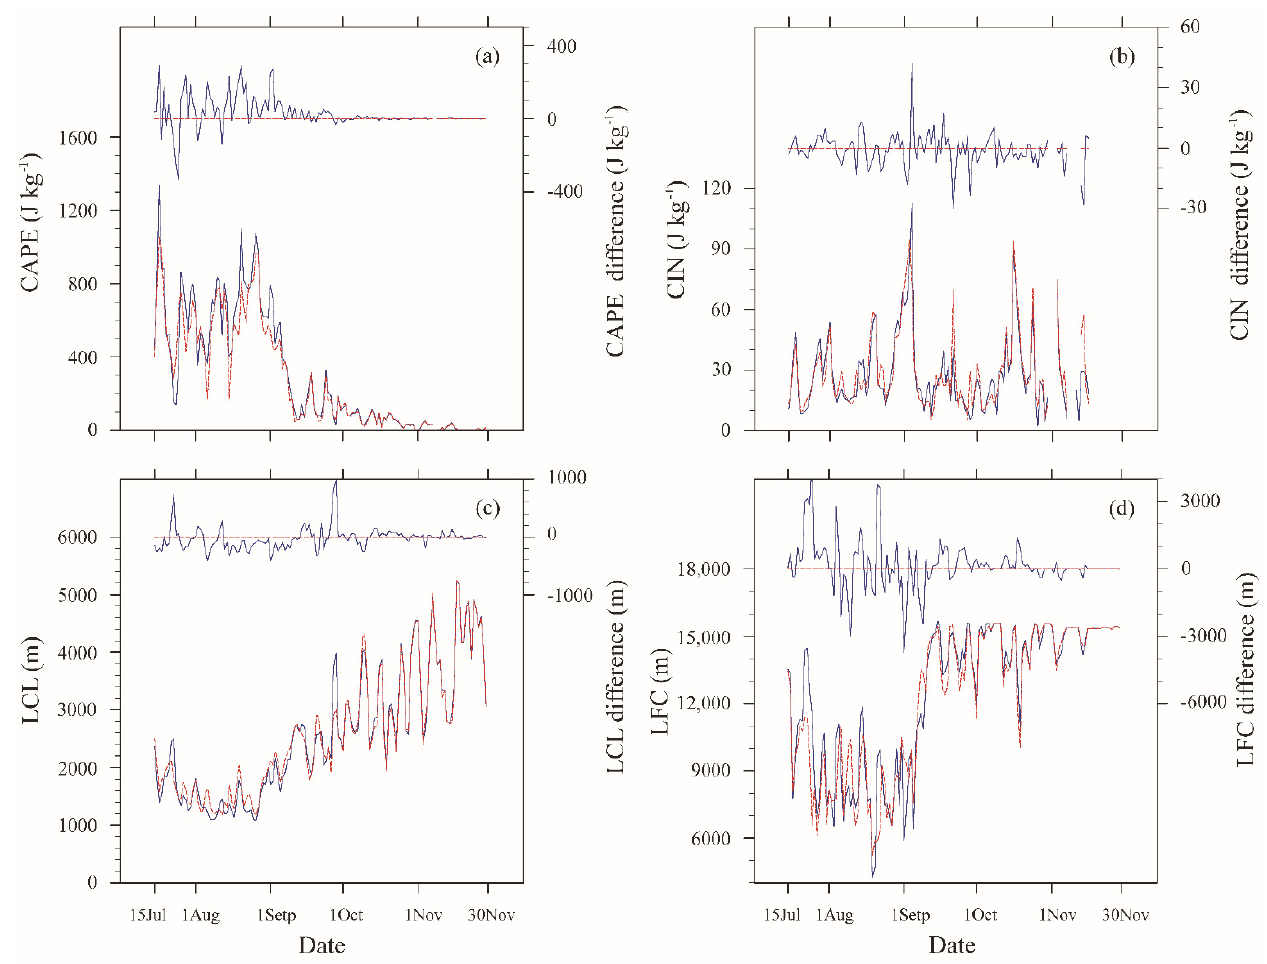
Figure 10. Temporal variations of the TRSR basin averaged values for the boundary layer elements ( a ) CAPE, ( b ) CIN, ( c ) LCL, ( d ) LFC. The curve on the lower half corresponds to the Y − axis on the left, with the red line representing WRF − H and the blue line representing WRF − S. The curve on the upper half corresponds to the y − axis on the right side, and the red line represents the bias of WRF − H relative to WRF − S.